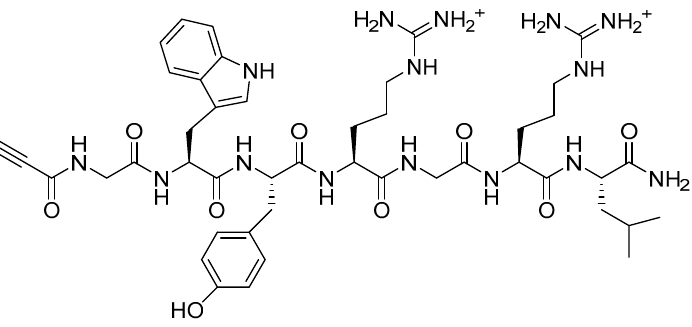
Figure 3. Propiolyl-GWYRGRL-NH 2